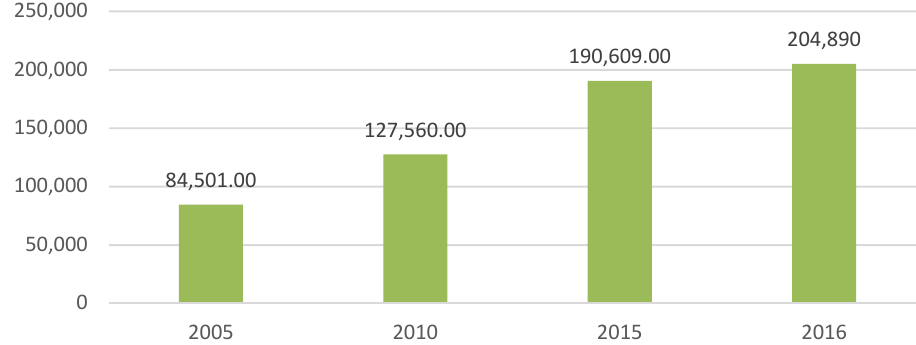
Figure 7. Sales of logistics, transport, and warehousing services in million Polish zlotys in the period 2005 to 2016 (Source: Main Office of Statistics, 2017b).